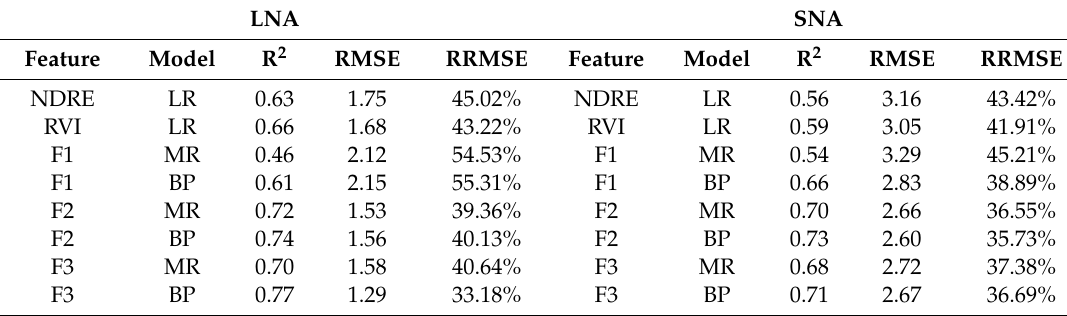
Table 7. Comparison of LNA and SNA estimates derived from di ff erent features in all